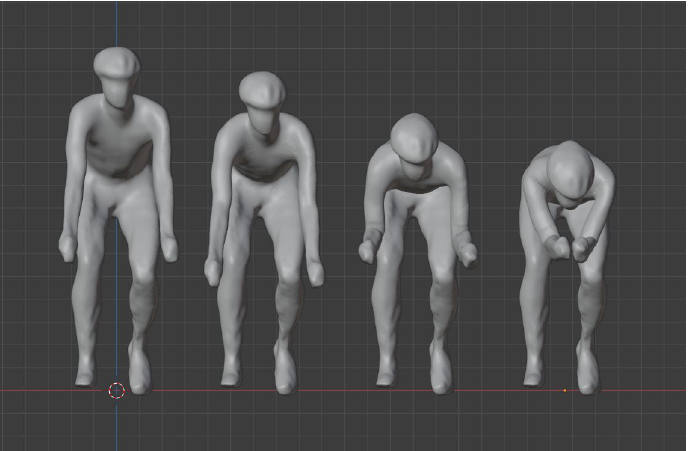
Figure 1. Frontviews of cyclist positions. From left to right: HH, HD, DB, TT.